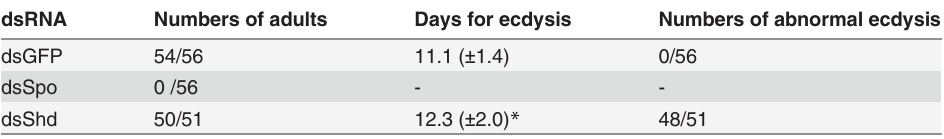
Table 3. Effects of dsRNA injection on ecdysis of final instar nymphs.